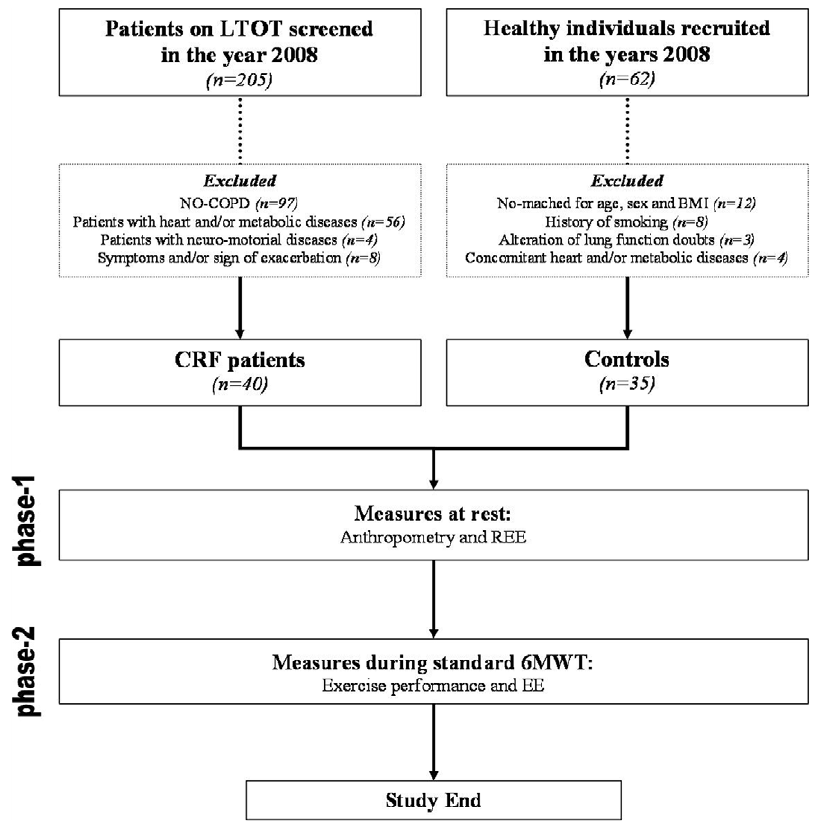
Figure 1. Study flow diagram.